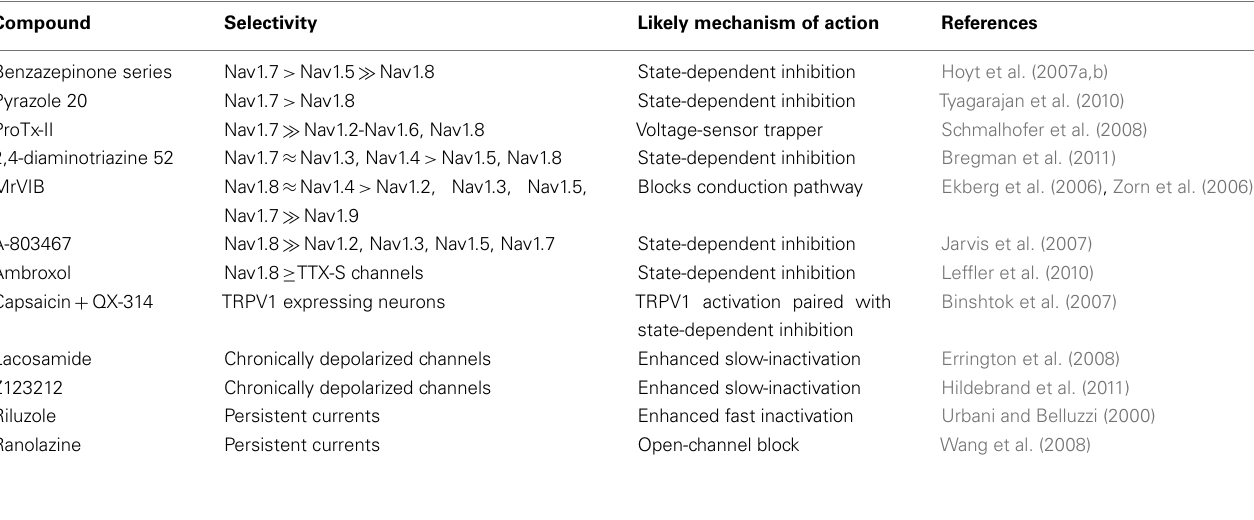
Table 2 | Summary of voltage-gated sodium channel